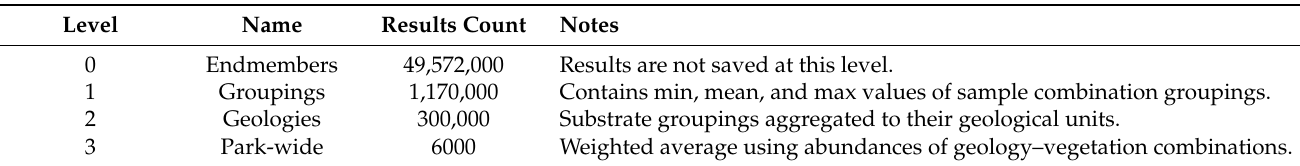
Table 4. Result aggregation level details.